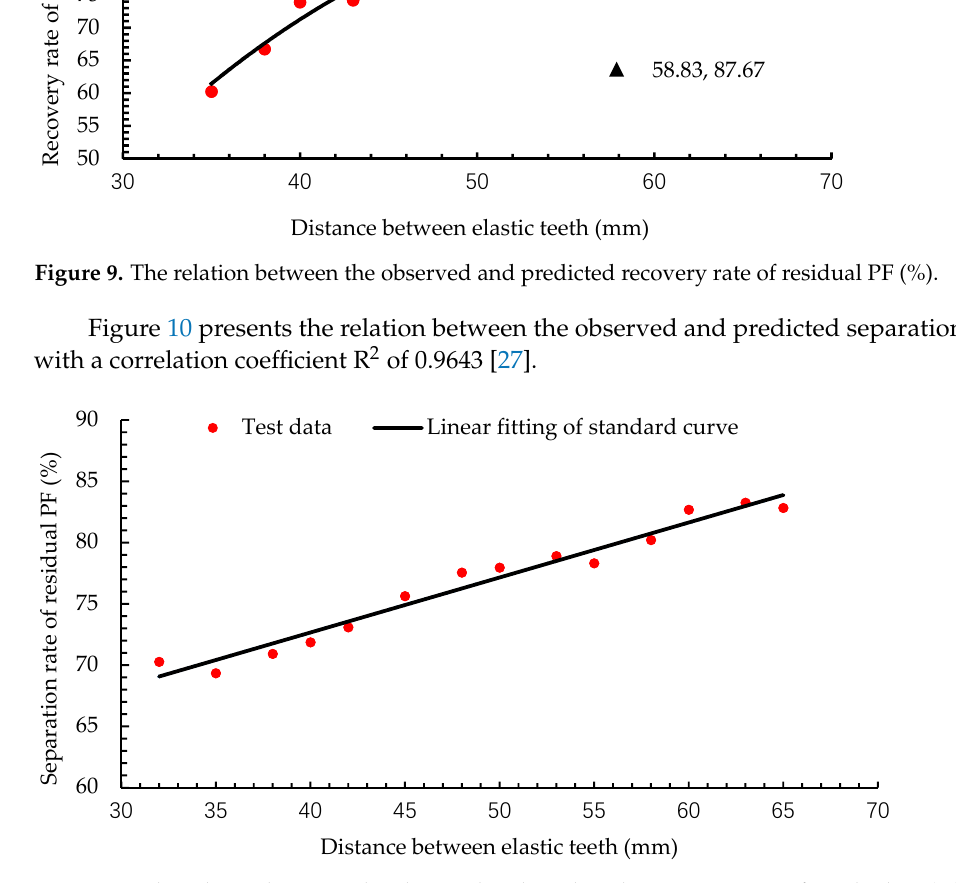
Figure 10. The relation between the observed and predicted separation rate of residual PF (%).